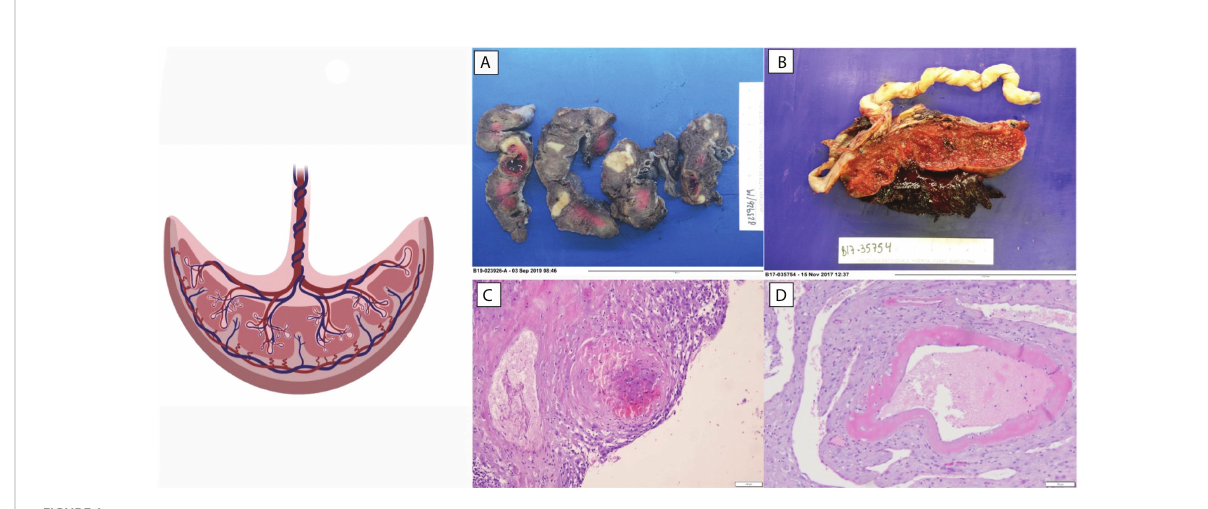
FIGURE 1 Histopathologic changes observed in placentas of patients with SLE. (A) Extensive infarction. (B) Abruptio placenta. (C) Decidual vasculopathy. (D) Decidua